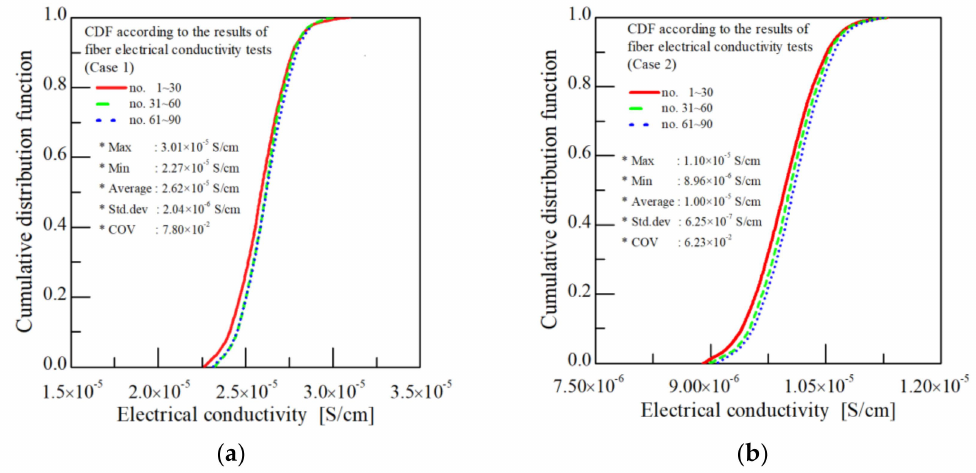
Figure 11. Cumulative distribution functions for electrical conductivity. ( a ) Case 1 ( x 1 : x 2 : x 3 : x 4 = 40:60:120:200); ( b ) Case 2( x 1 : x 2 : x 3 : x 4 = 60:60:120:200).